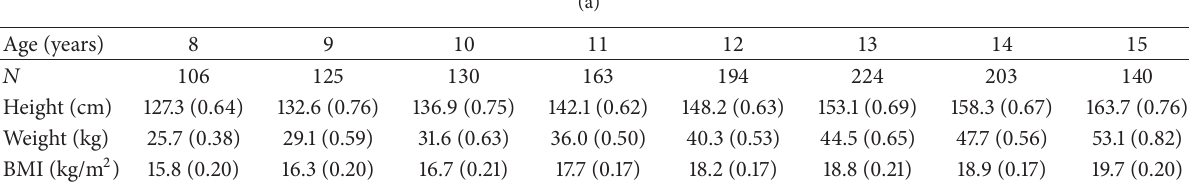
Table 1: (a) Descriptive statistics for height, weight, and body mass index (BMI) of boys in our study population. (b) Descriptive statistics for height, weight, and body mass index (BMI) of girls in our study